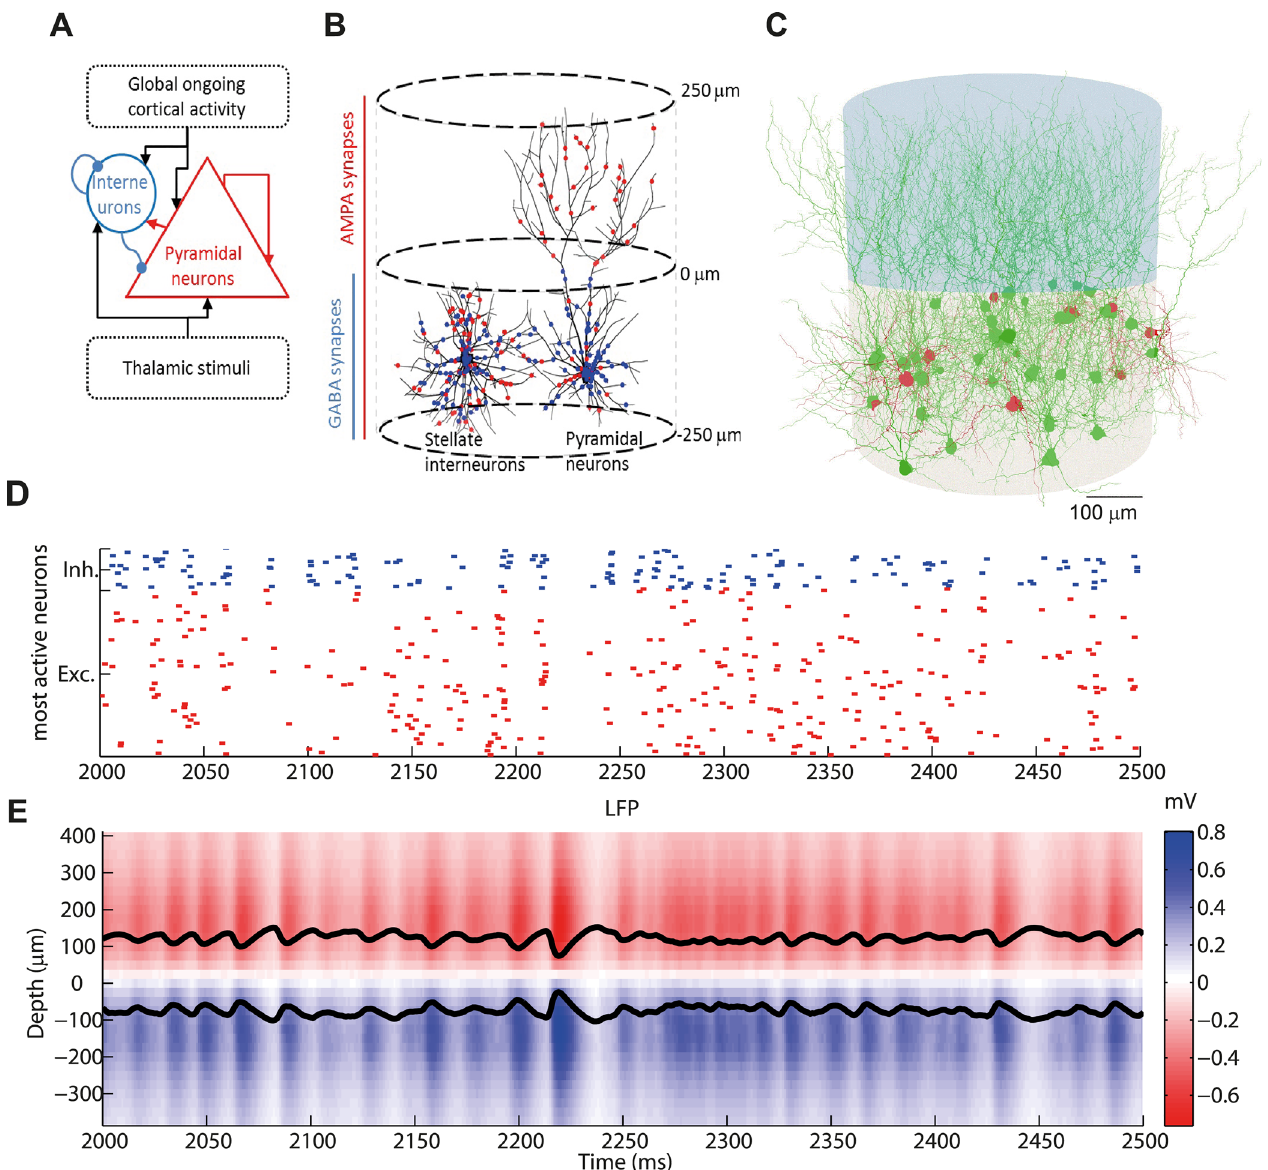
Fig 1. LIF network and 3D morphological network. (A) Sketch of the leaky integrate-and-fire (LIF) network. A population of 1000 interneurons with GABA synapses (blue) and a population of 4000 pyramidal neurons with AMPA synapses (red) receive recurrent inputs (random connectivity with 20% probability) and two kinds of external inputs: global ongoing cortical activity (Ornstein-Uhlenbeck process) and a regular thalamic stimulation. (B) Sketch of the morphological 3D network made of two stacked cylinders with 250 μ m radius and 250 μ m height. A representative interneuron and pyramidal cell are depicted. Interneuron dendrites remain in the lower cylinder while the pyramidal neuron dendrites reach out to the upper cylinder. Dendrites in the lower cylinder receive both AMPA and GABA synapses while dendrites in the upper cylinder receive only AMPA synapses. (C) Graphical rendering of a subset of the 3D network composed of 10 interneurons and 40 pyramidal neurons. (D) Raster plot of the spiking activity of the 10 interneurons (blue, top) and the 40 pyramidal neurons (red, bottom) with the highest spiking activity in the LIF network, for a thalamic stimulation of 1.5 spikes/ms. (E) Depth-resolved LFP signal as simulated by injecting the spikes generated by the whole network during thalamic stimulation of 1.5 spikes/ms into the 3D network. Black lines show LFP for 100 and -100 μ m